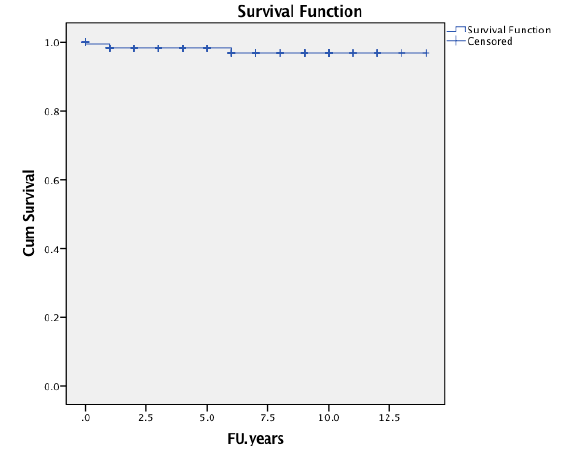
Figure 7. Kaplan-Meier implant survival curve with the endpoint of stem revision for aseptic loosening at the observed